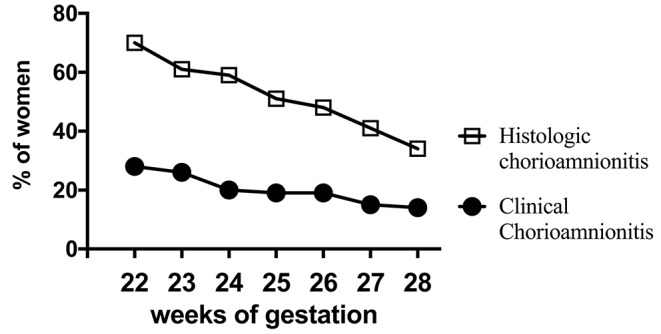
Chorioamnionitis during second trimester. Higher documentation of histologic vs. clinically diagnosed chorioamnionitis in the same mothers whose Infants were born at 22–28 weeks Gestational Age (GA) in the NICHD funded Neonatal Network database (2003-2007). Also note that chorioamnionitis is more frequently diagnosed at earlier gestations (inverse correlation of gestational age with incidence of chorioamnionitis). Adapted from Stoll et al. (23).